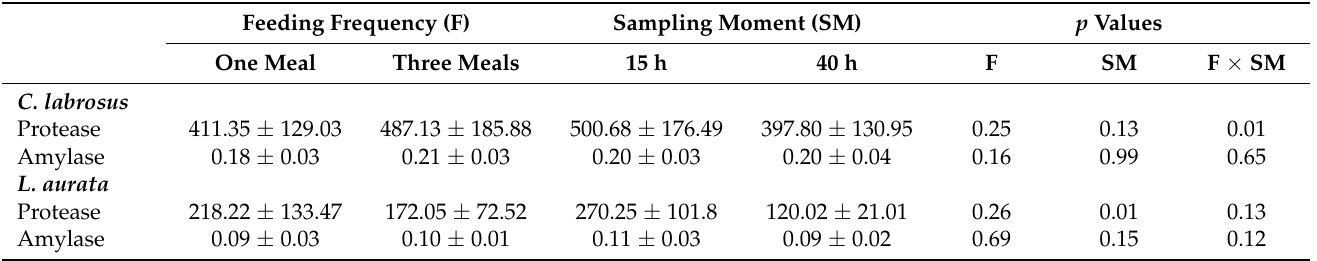
Figure 1. Average activity of total alkaline protease ( a ) and amylase ( b ) (U/g live weight) in the intestines of C. labrosus and L. aurata juveniles (n = 36). Data expressed as means ± standard deviation (SD). Significant differences between species ( p < 0.05) are indicated using lowercase letters (a, b). Table 5. Protease and amylase activities (U/g live weight) of C. labrosus and L. aurata as a function of the number of daily meals and sampling moment, expressed as sampling moment (SM) and feeding frequency (F) (n = 18).